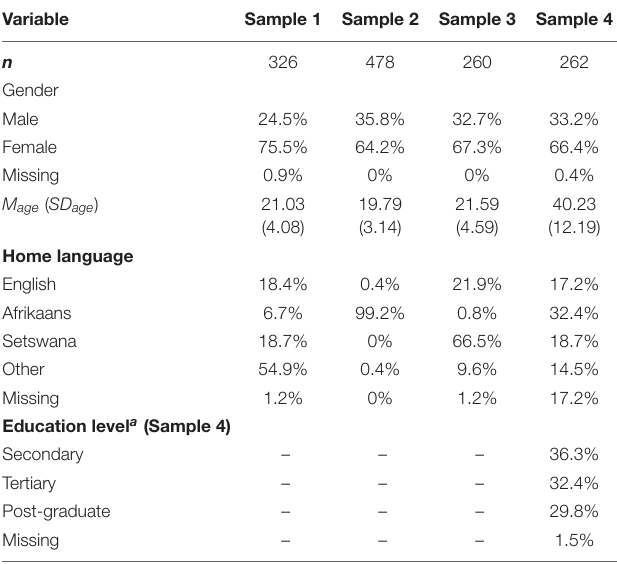
TABLE 1 | Socio-demographic profile of participants.